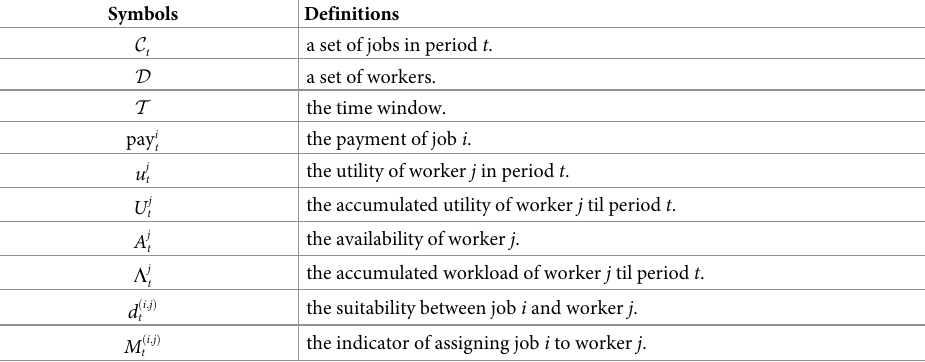
Table 1. A brief overview of